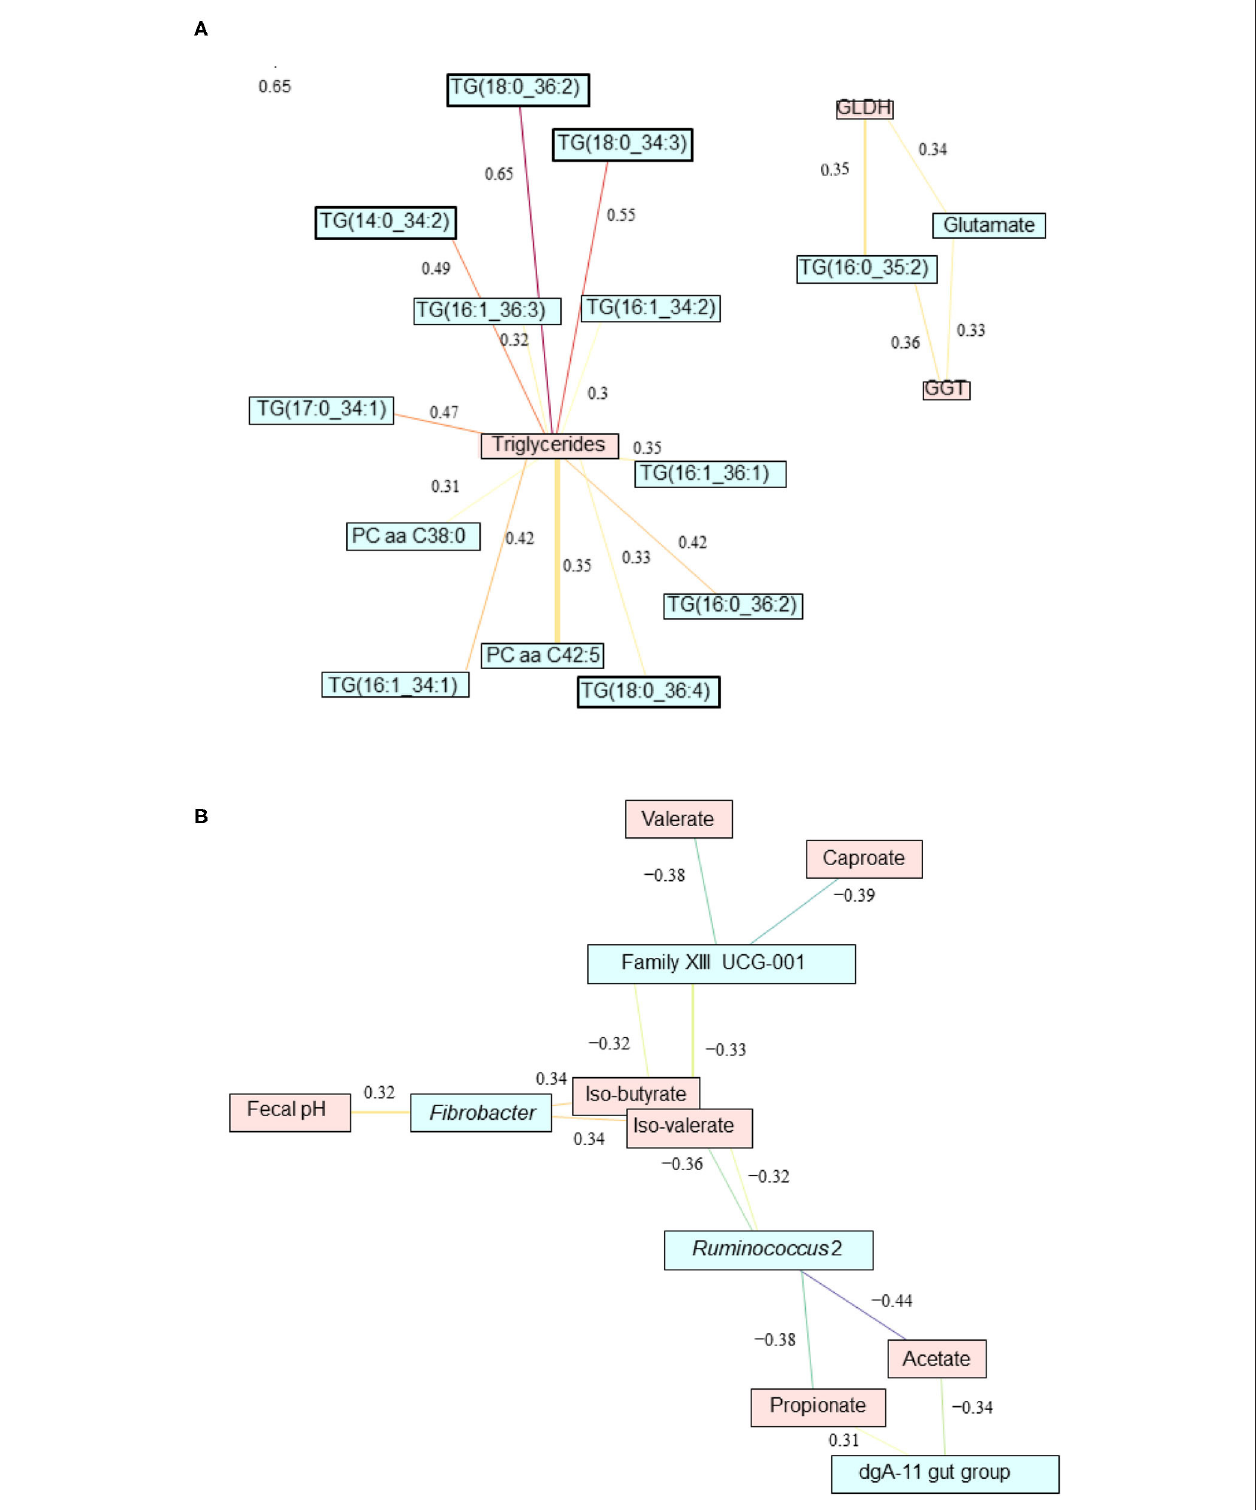
FIGURE 7 | Relevance network analysis showing the most significant pairwise associations (A) between liver parameters and serum metabolome and (B) between fecal microbiota and fermentation profile impacted by feed additive feeding assessed using sparse partial least squares regression (|r| = 0.3).